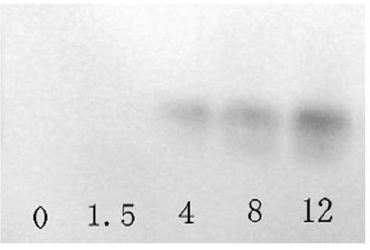
Figure 6. Western-blot analyses of Ca-HMGB in the superna- tant of hemocyte monolayers. Samples were collected at 0, 1.5, 4, 8 and 12 h after RLO (1ul/10 6 cells) incubation.